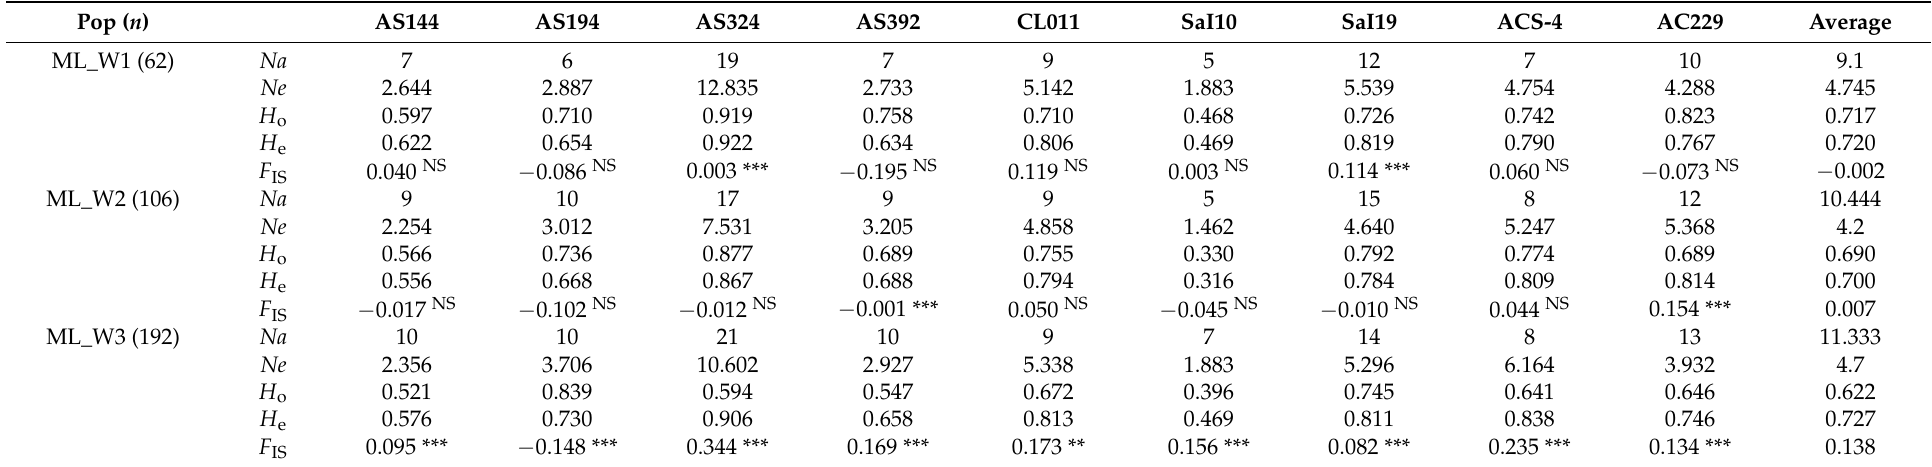
Table 5. Summary statistics for genetic variation at nine microsatellite loci in 10 wild black sea bream